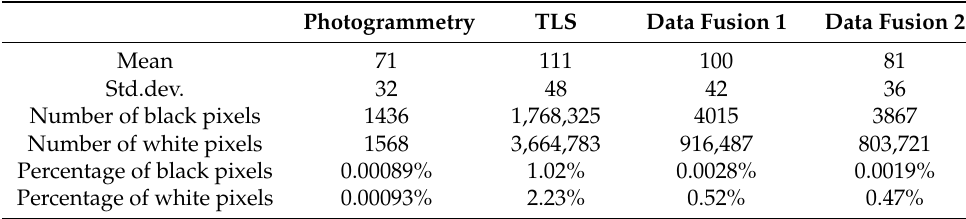
Figure 18. A histogram analysis of all texture atlases for the four modelling methods: photogram- metry, TLS, Data fusion 1 using common method, and data fusion 2 using the proposed method. Table 8. Summary of the image histogram analysis.